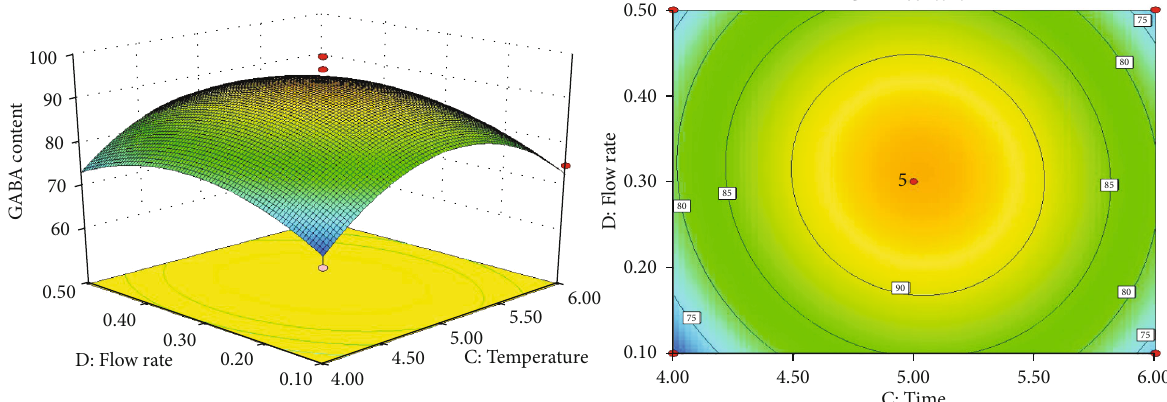
Figure 11: Response surface and contour diagram of time and fl ow rate in fl uence on GABA